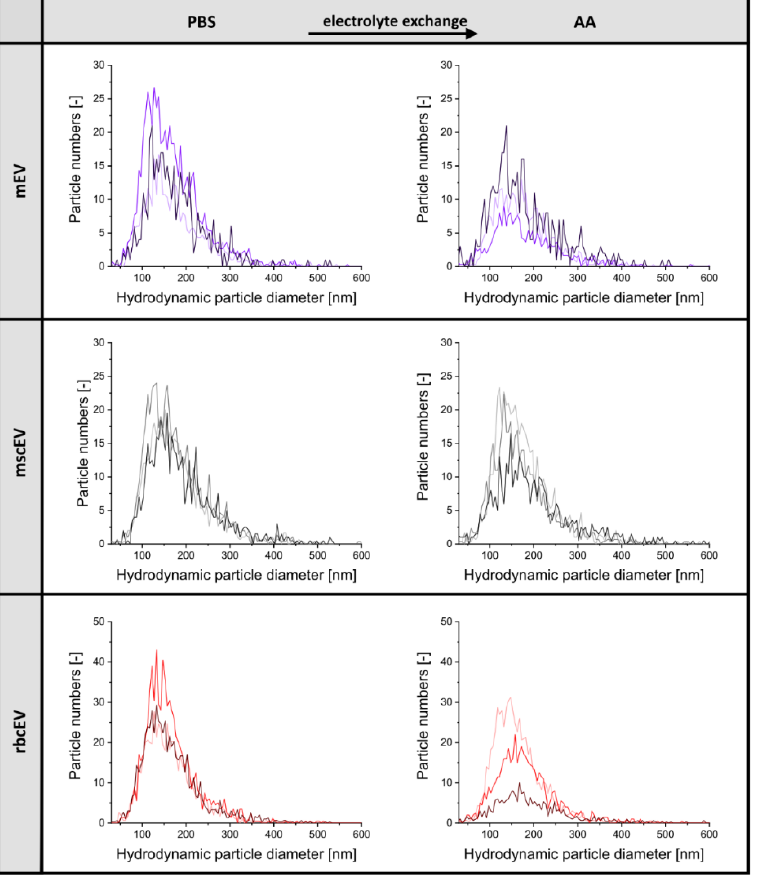
Figure 2. Comparison of EVs from different cell types (mEV, mscEV and rbcEV) and investigation of the impact of the electrolyte exchange from phosphate buffered saline (PBS) to ammonium acetate (AA) on the particle numbers and the hydrodynamic particle size distribution (NTA-derived).